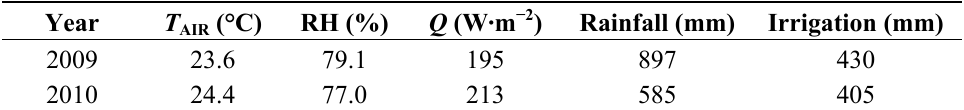
Table 1. Average daily air temperature ( T radiation ( Q ), total rainfall and total irrigation for the 2009 and 2010 growing seasons (April–November) at Citra, Florida,